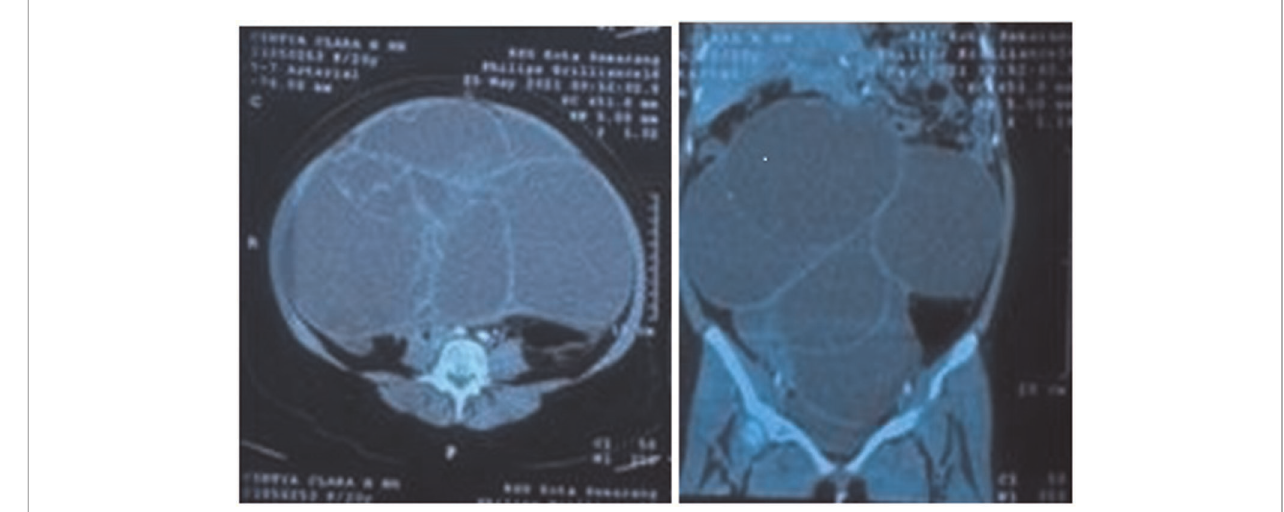
FIGURE 2 | Abdominal CT-scan revelaed a giant lobulated cyst in the abdominal and pelvic cavity.